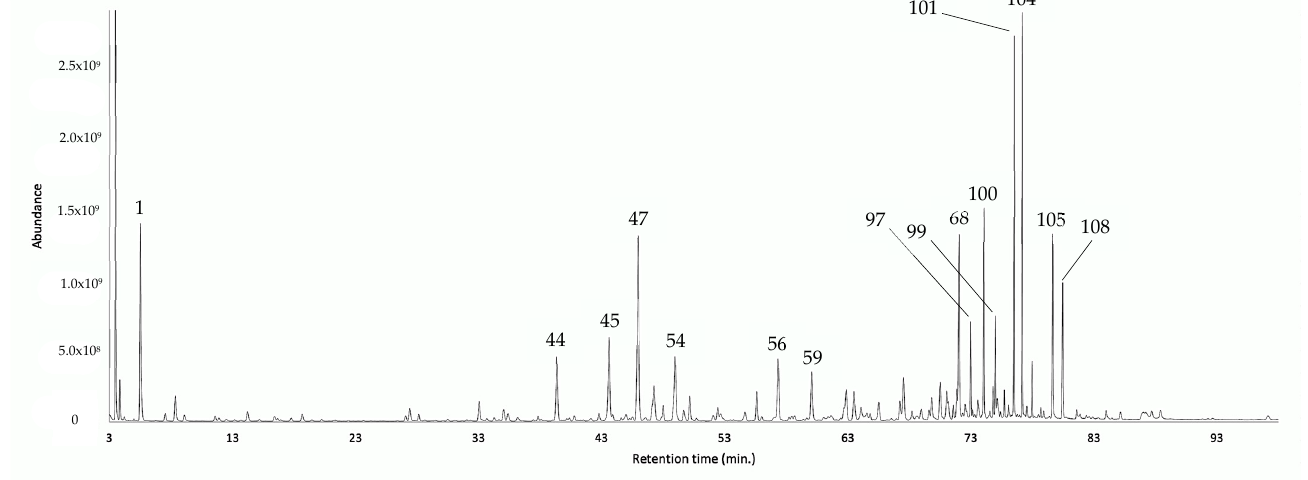
Figure 3. GC–MS chromatogram of the EO from the leaves of G. rugulosa in a polyethylene glycol- based column. The main components are represented with the respective peak number, according to Table 1.